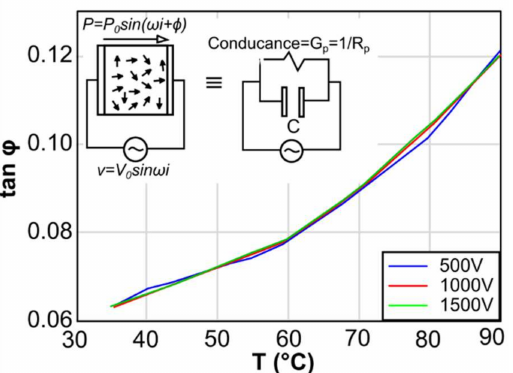
Figure 6. Dielectric loss tangent of the PCC material under different temperatures and voltages and an idealisation of the dielectric medium as the capacitor and resistor (top right